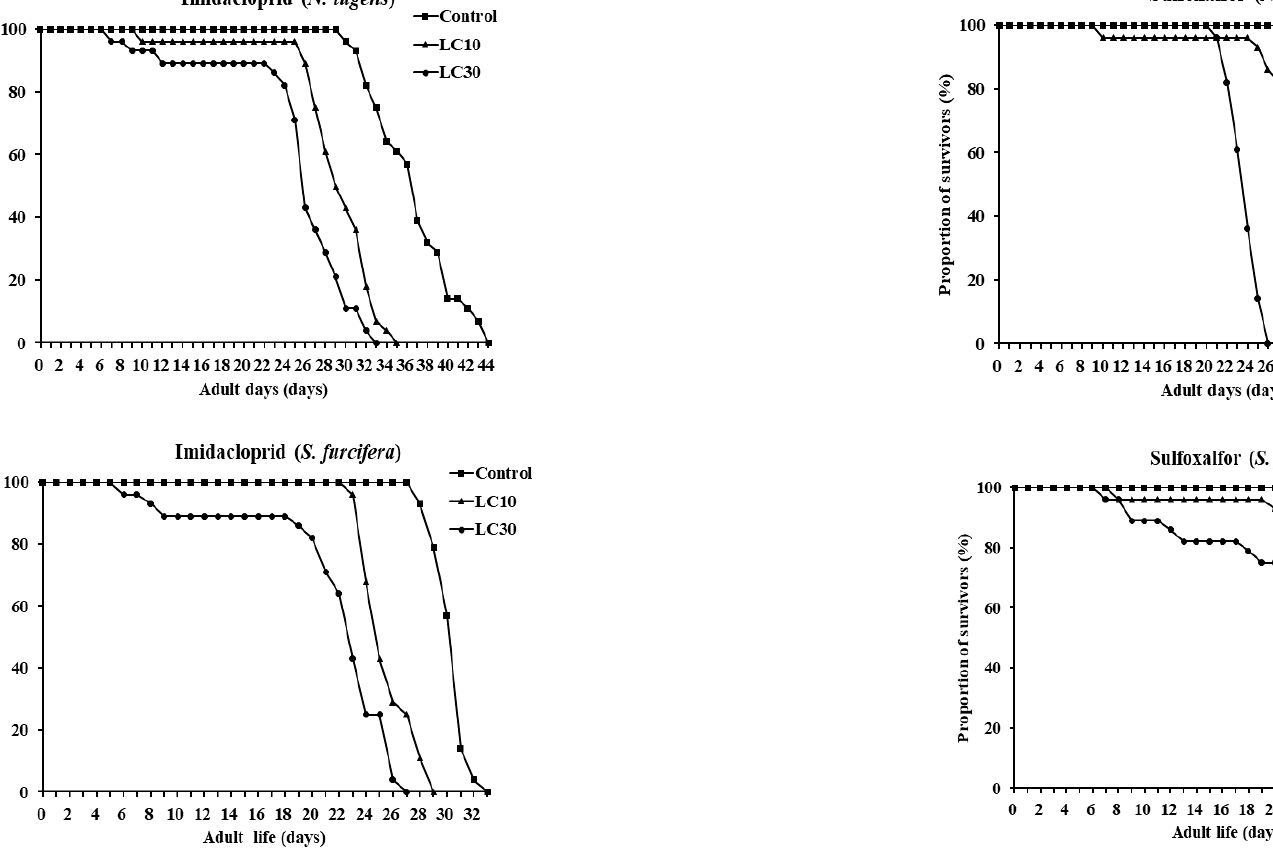
Figure 6. Survival rates (%) of N. lugens ( top ) and S. furcifera ( bottom ) affected by sublethal concentrations of the two insecticides. Squares are untreated-, triangles are LC 10 - and circles are LC 30 -treated group. The vertical axis represents daily survival rates of N. lugens and S. furcifera from the first-instar nymph to the death of the adults.